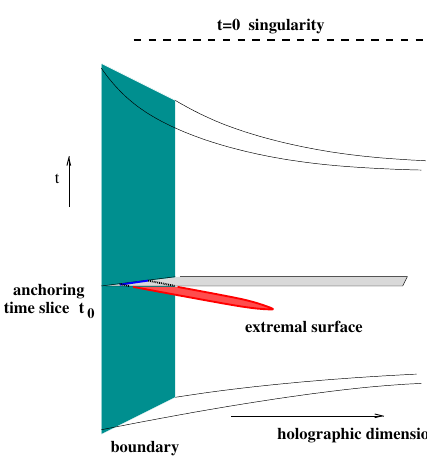
Figure 1 . Cartoon of extremal surfaces in AdS Kasner spacetime, anchored on a boundary time slice t 0 (extended as the grey horizontal plane in the bulk). The extremal surface (red) bends away from the singularity at t = 0 (dotted line), i.e. t ∗ > t 0 , with ( t ∗ , r ∗ ) the turning